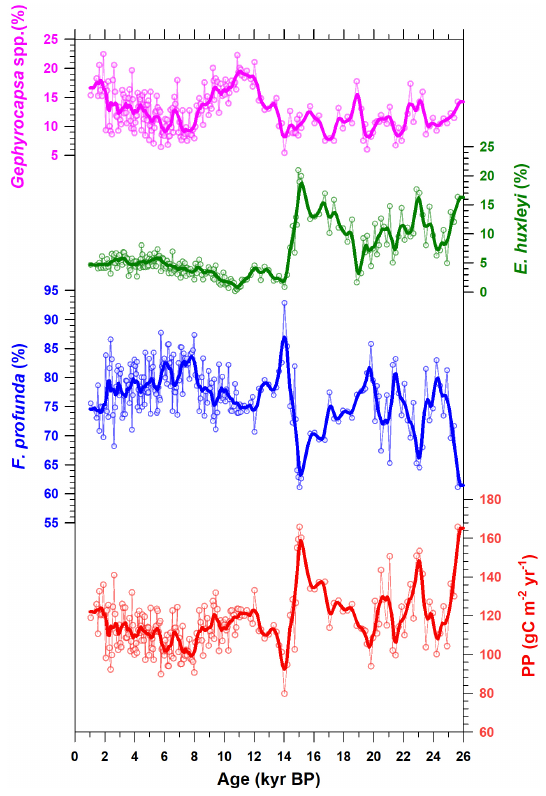
Figure 2. Relative abundance changes (%) of main coccolith species and reconstructed PP of core MD77-176: Gephyrocapsa spp. (pink), Emiliania huxleyi (green), Florisphaera profunda (blue), PP (red). The curves are smoothed results (five-point moving average of 0.1kyr interpolation of original